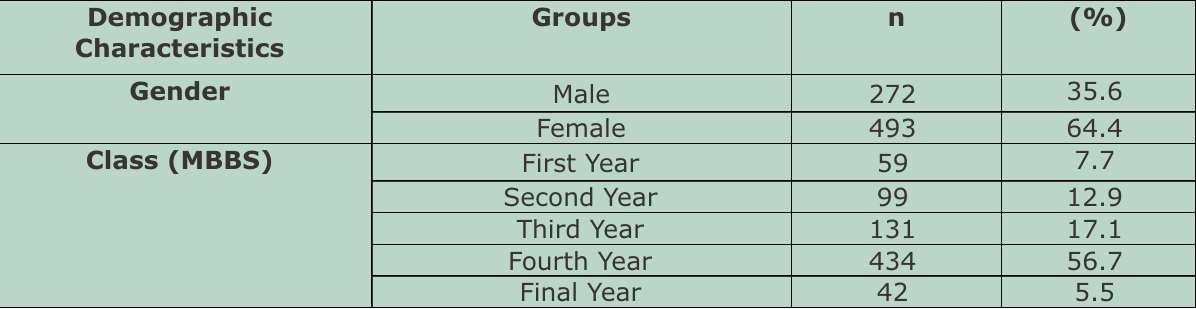
Table-I: Frequency distribution of demographic characteristics among undergraduate. Medical students (n=765).